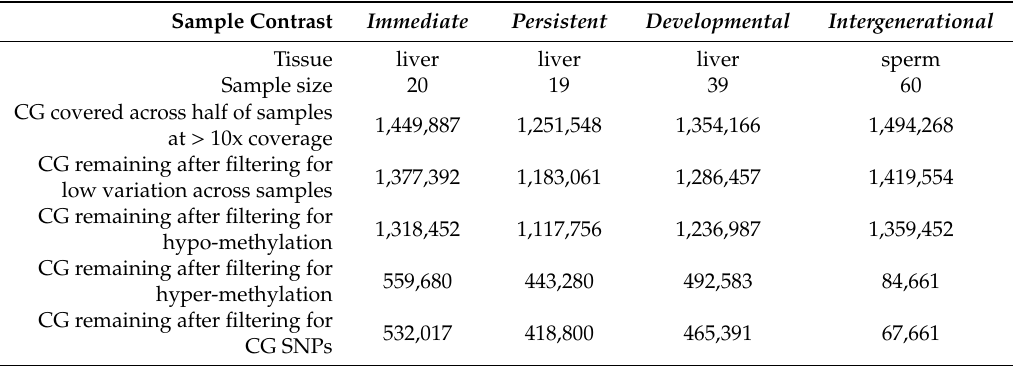
Table 1. Breakdown of number of CG dinucleotides filtered for each sample contrast. The final row, “CG remaining after filtering for CG single nucleotide polymorphisms (SNPs)”, represents the number of CG analyzed for di ff erential methylation analysis for each sample